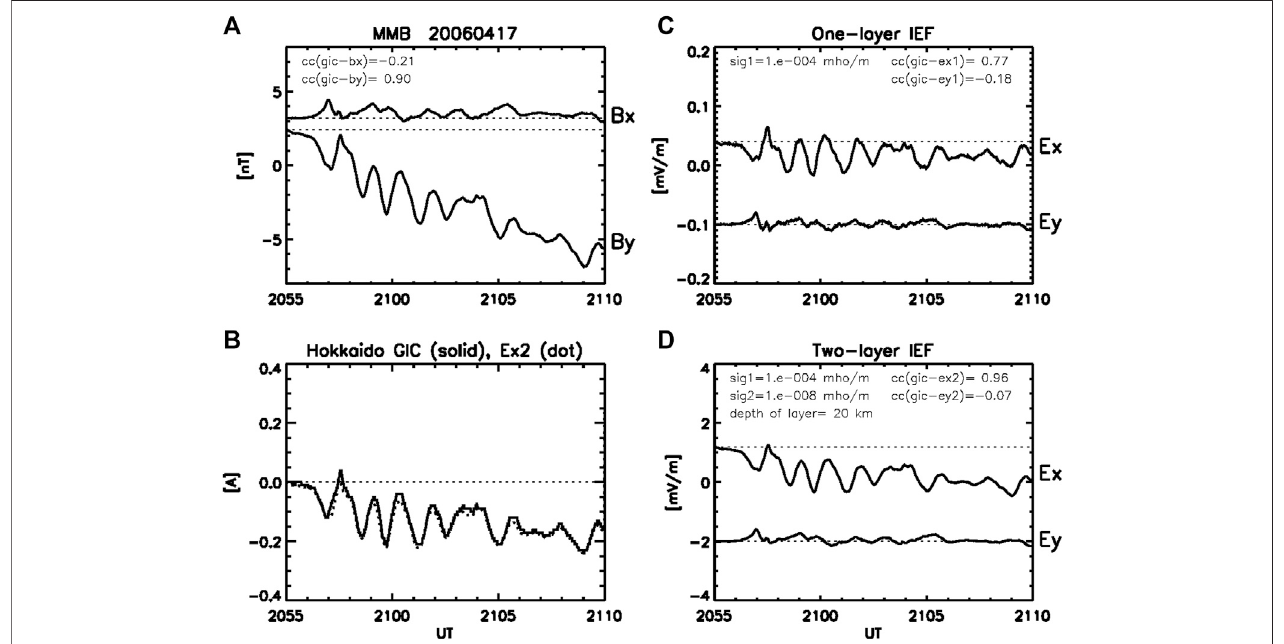
FIGURE1|(A) X-andY-componentsofthemagnetic fi eld( B x , B y )observedattheMemambetsu(MMB)magneticobservatoryduringthePi2eventwiththeperiod of1 mininthemorningsector(21UT,06MLT). (B) GICobservedattheMemambetsusubstationoftheHokkaidoElectricCompany(solidcurve). E x2 scaledtotheGICis plotted with the dotted curve in the frame of the GIC, so that one can see the high correlation between the GIC and E x2 . (C, D) The induced electric fi elds (IEF), E y,x inducedby B x,y atthesurfaceoftheEarthintheone-andtwo-layermodels.Sig1 (cid:1) 10 – 4 mho/ mintheone-layermodeldenotestheconductivityofthesemi-in fi nite uniform conductor. The parameters of the two-layer model are sig1 (cid:1) 10 – 4 mho/ m and depth (cid:1) 20 km of the upper layer and sig2 (cid:1) 10 – 8 mho/ m of the semi-in fi nite lower layer. The cc refers to the correlation coef fi cient between the GIC and B x,y / E y,x .